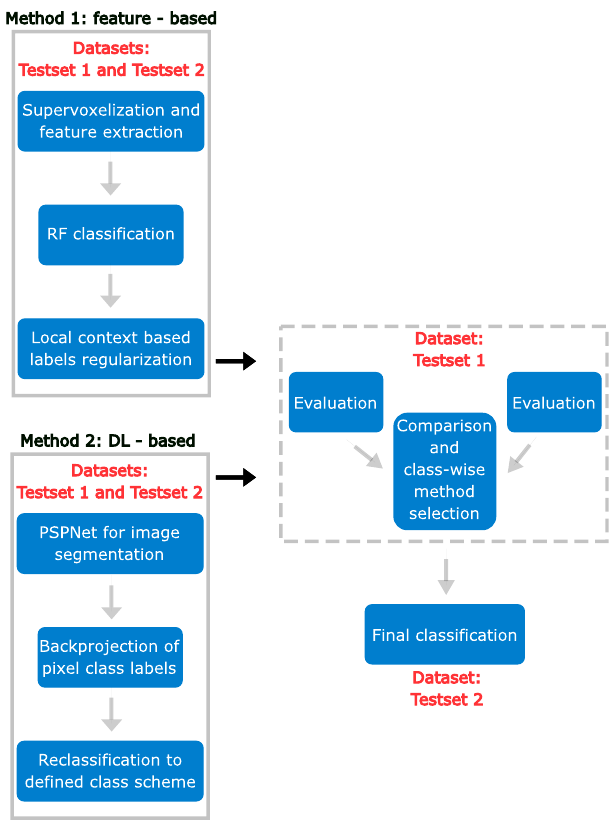
Figure 2. Workflow of the proposed